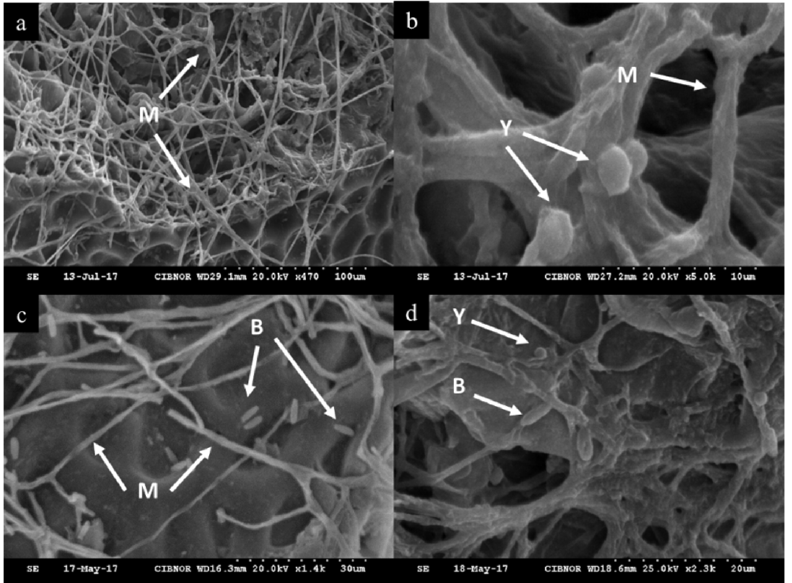
Figure 2. Scanning electron micrograph imaging of biocontrol activity of microbial antagonists against F. proliferatum in muskmelon fruit. ( a ) Mycelium of F. proliferatum ; ( b ) Mycelium of F. proliferatum and cells of D. hansenii ; ( c ) Mycelium of F. proliferatum and cells of S. rhizophila ; ( d ) Mycelium of F. proliferatum and cells of D. hansenii and S. rhizophila . M = mycelium of F. proliferatum , Y = D. hansenii , and B = S. rhizophila .